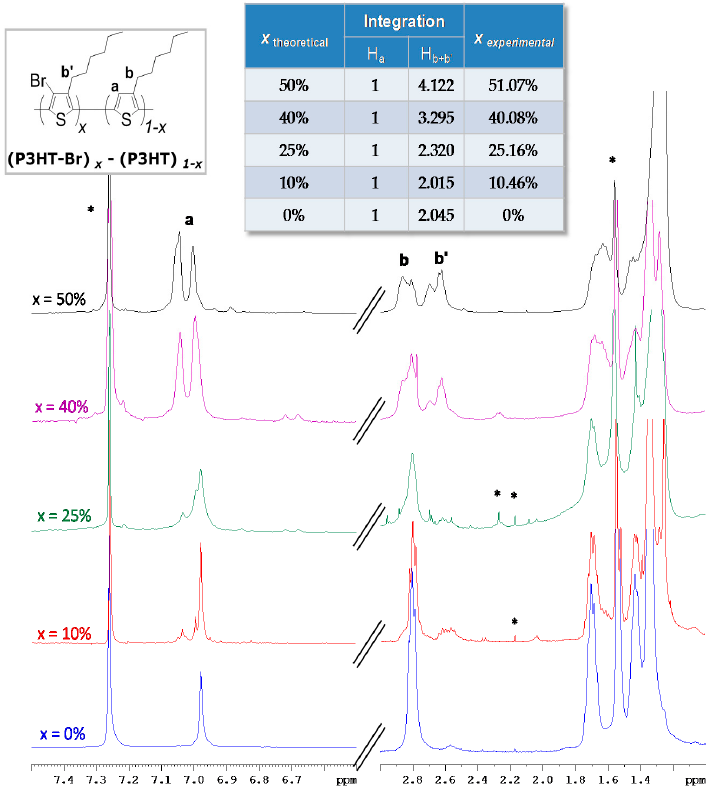
Figure 1. 1 H NMR spectra of the various side bromine functionalized P3HTs, in CDCl 3 (the asterisks indicate solvent traces).